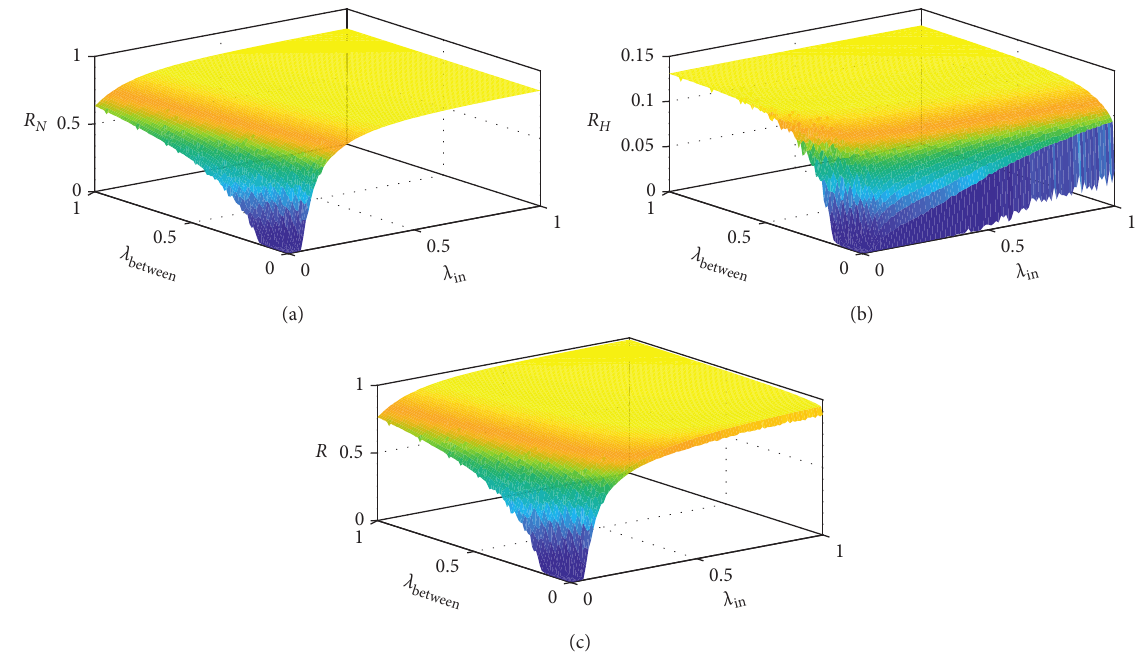
Figure 6: Information spreading on null model networks.